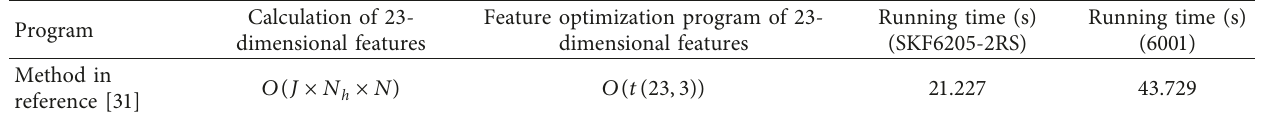
Figure 10: Fractional lower-order features proposed in this paper. (a) Fault set 1. (b) Fault set 2. (c) Fault set 3. (d) Fault set 4. Table 6: Computational complexity of programs in reference [30].